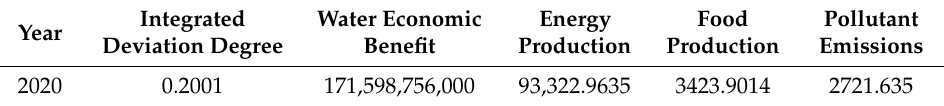
Table 9. Objective values of the optimization model of the water–energy–food system in